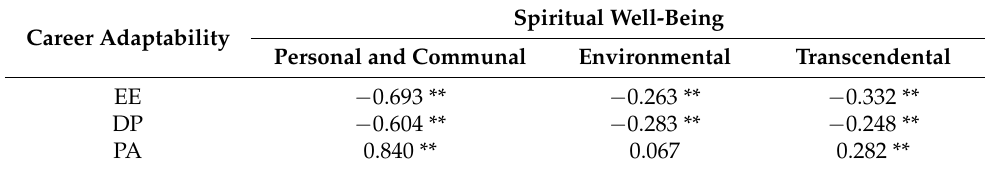
Spiritual Well-Being